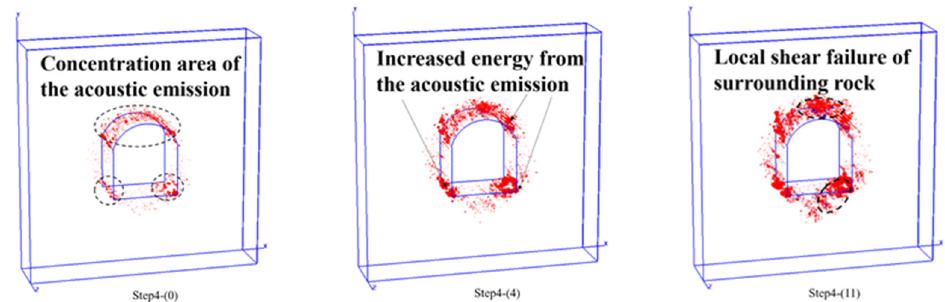
Figure 7. Acoustic emissions during the tunnel failure.